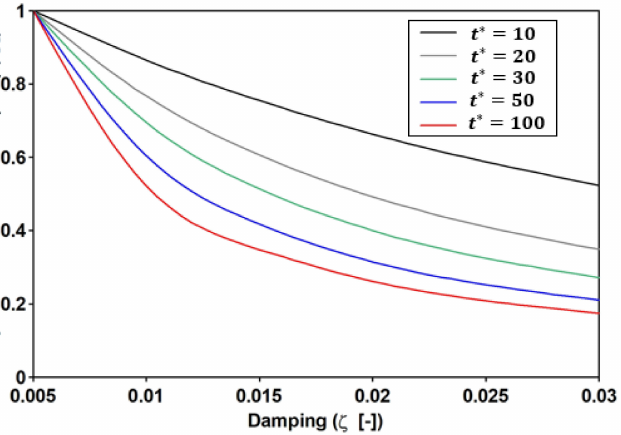
Figure 13. The SDOF that is subjected to a harmonically varying load force; specifically, the normal- ized general solution. Table 14. Peak acceleration ( PAV at the P3 station) vs. the frequency-dependent damping. Variant